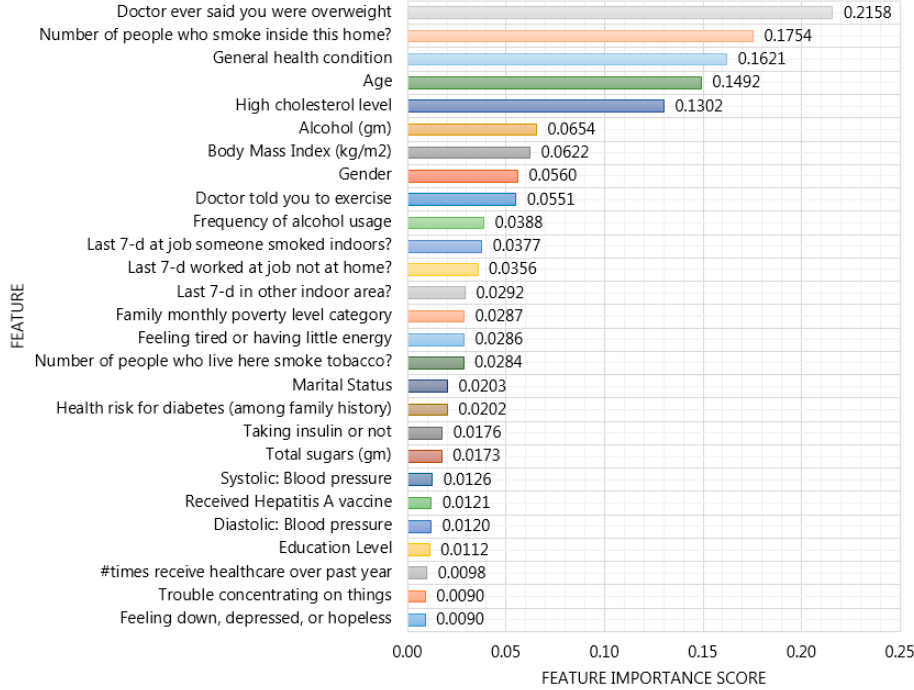
Figure 9. Feature Importance of XGBoost based framework incorporated with hybrid feature selection in the NHANES dataset.